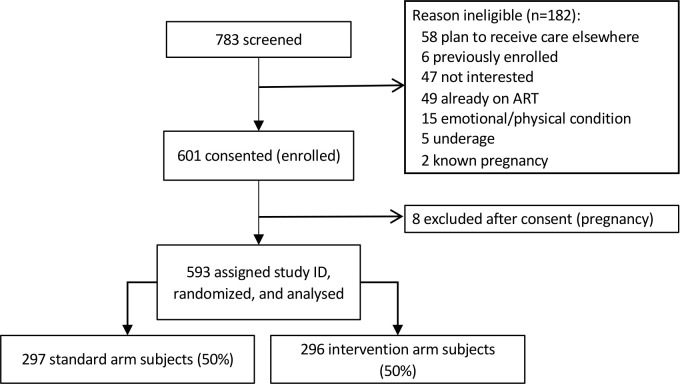
CONSORT flow diagram for the SLATE II randomized trial of same-day treatment initiation.ART, antiretroviral therapy; ID, identifier; SLATE, Simplified Algorithm for Treatment Eligibility; CONSORT, Consolidated Standards of Reporting Trials.